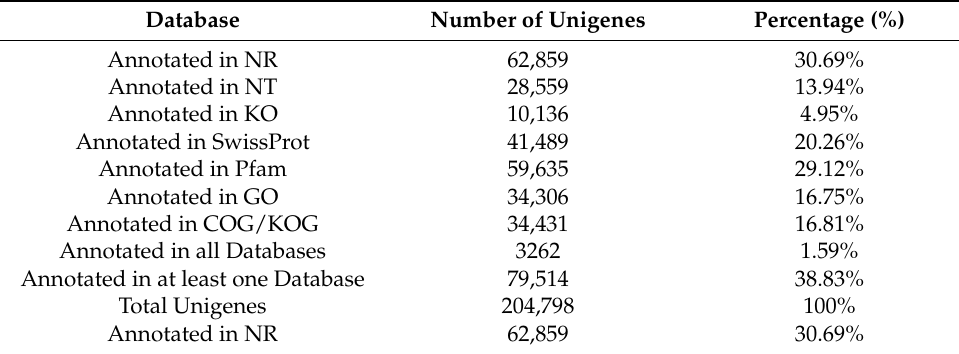
Table 2. Functional annotation of the P. orientalis